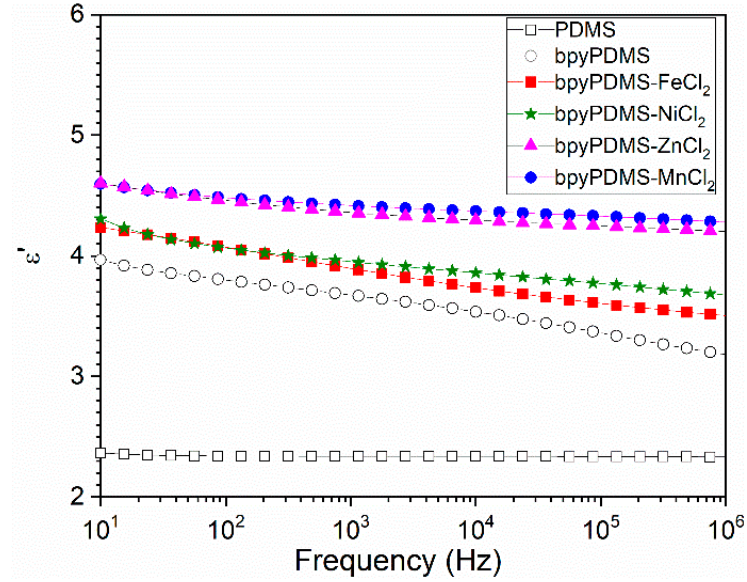
Figure 4. Frequency dependence of real part of dielectric permittivity ε′ at 293 K of PDMS, and metalloorganic complexes.